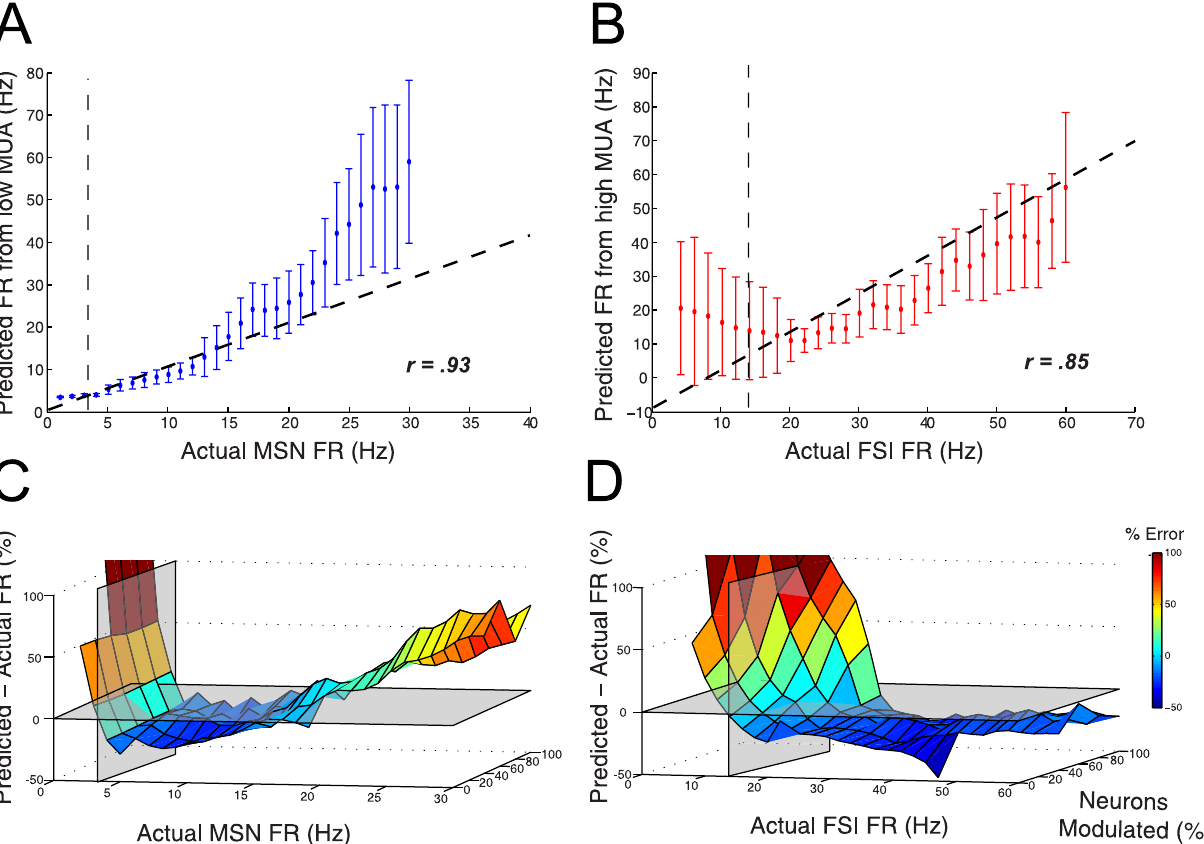
Fig 8. Accuracy of MUA predicting evoked population dynamics depends on population parameters. A-B) Comparison of actual and predicted population firing rate for A) MSNs from low MUA (0.3 – 2 KHz) and B) FSIs from high MUA (8 – 10 KHz). Data is from simulation where 60% of neurons were modulated. Dotted vertical line denotes mean population firing rate. Dotted diagonal line represents unity line. Error bars denote S.D. Correlation value is from linear best-fit line. Note that at high population firing rates MSNs are not predicted well from low MUA, and at low population firing rates FSIs are not predicted well from high MUA. C-D) Surface plots of prediction error for C) MSNs and D) FSIs as a function of actual population firing rate and the percent of population responsive to input. Transparent planes represent mean firing rate of population (vertical plane) and 0% prediction error (horizontal